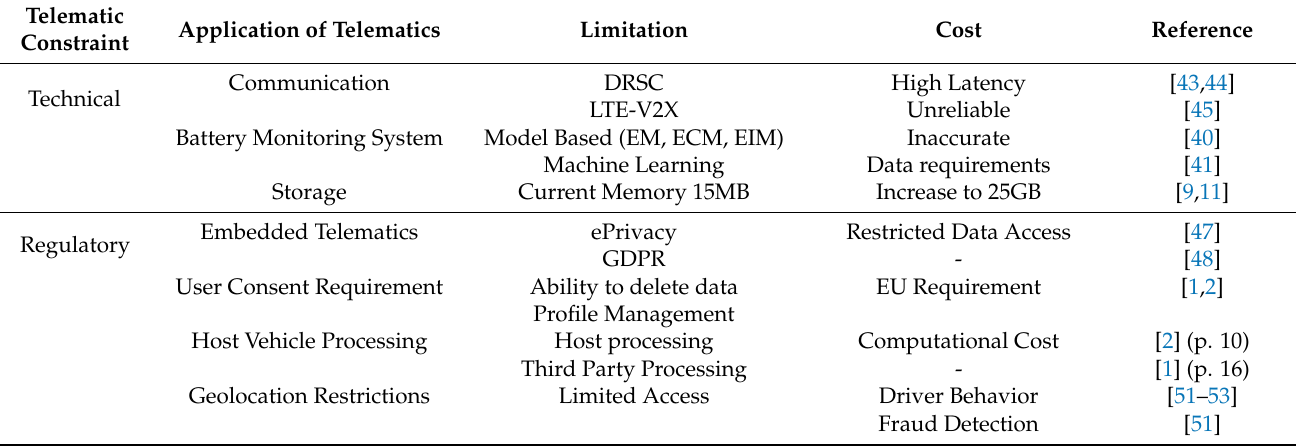
Table 1. Summary of Technical/Regulatory